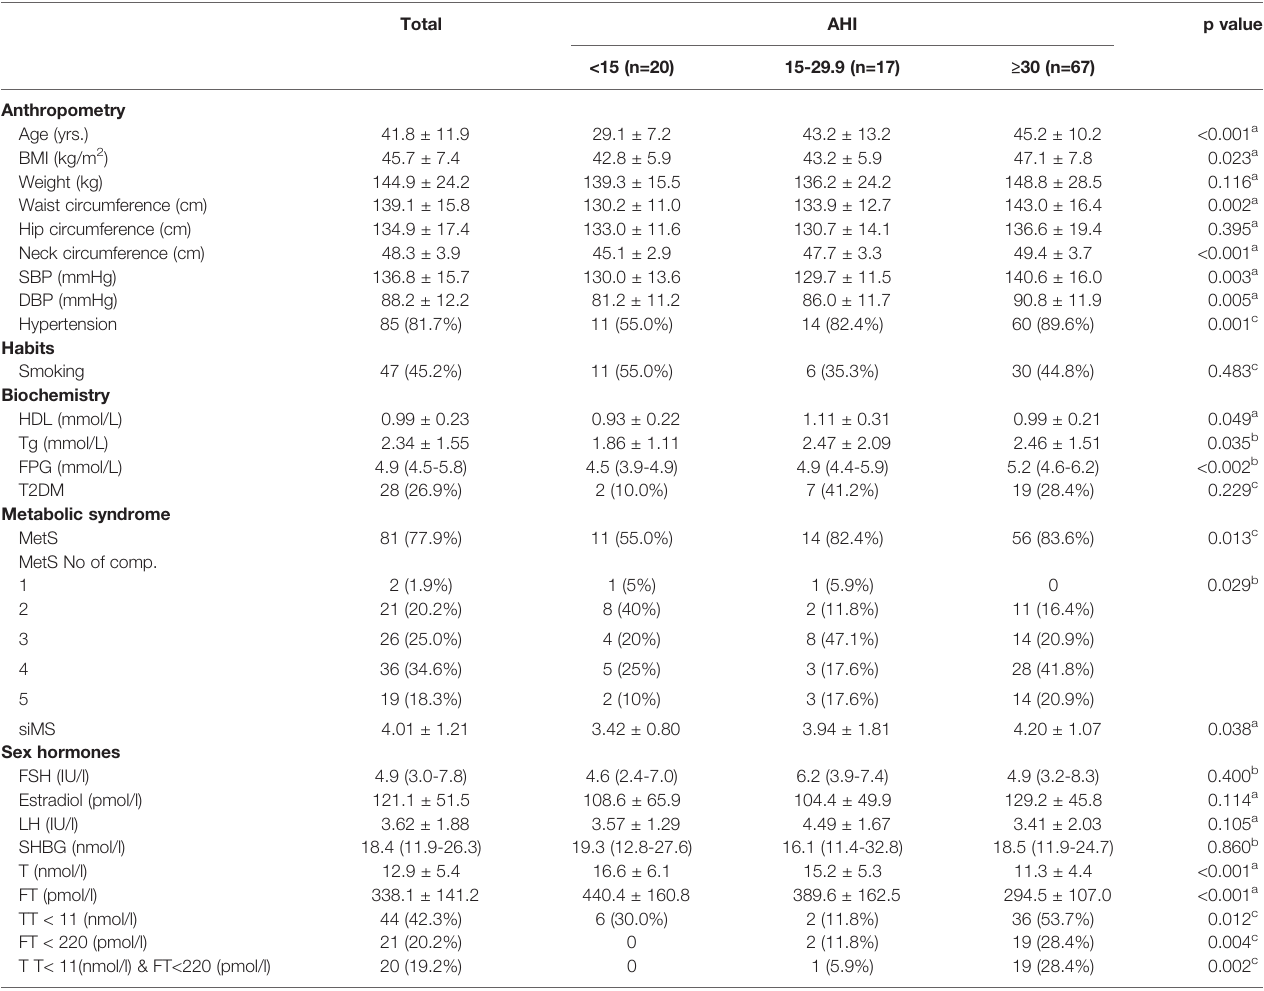
TABLE 1 | General characteristics of the total cohort and AHI groups.